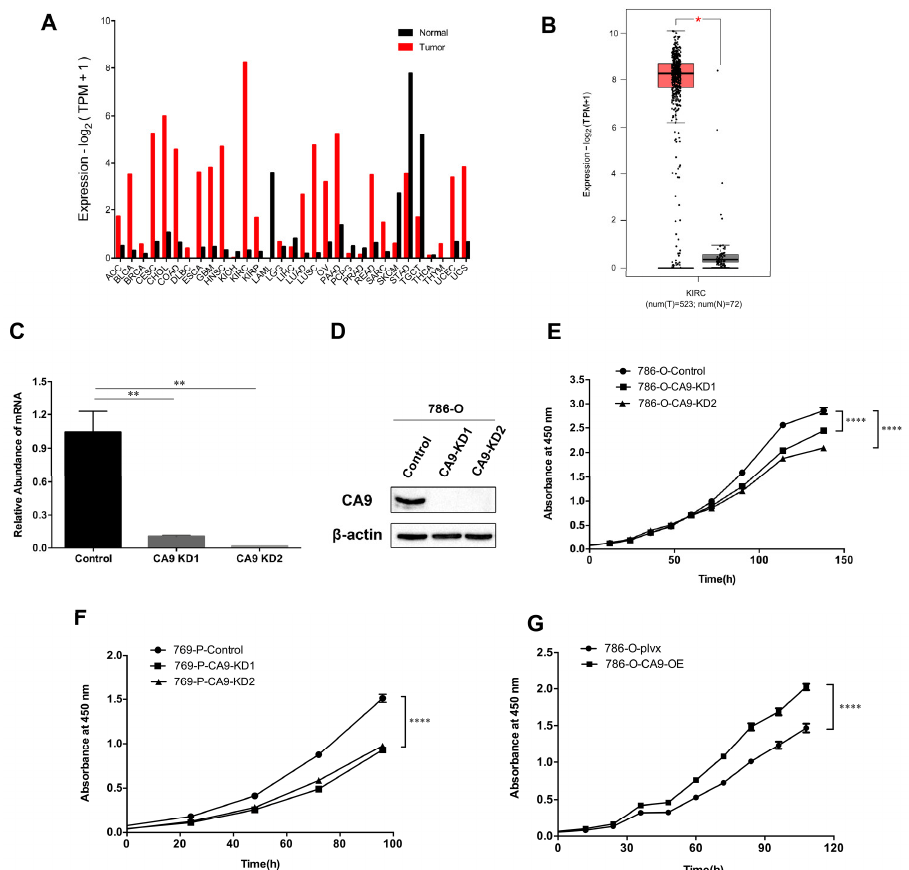
Figure 1. CA9 knockdown inhibits cell growth in clear cell renal cell carcinoma (ccRCC) cells. ( A ) CA9 expression profile across all tumor samples and paired normal tissues. The transcriptome datasets were obtained from The Cancer Genome Atlas (TCGA). Tumor abbreviations are listed in Table S1. ( B ) The mean mRNA level of CA9 in ccRCC tissues (num(T) = 523) and normal tissues (num(N) = 72) from TCGA data. ( C ) mRNA expression of CA9 decreased in 786-O-CA9-KD cells compared with control cells, measured by quantitative real-time PCR (qPCR). ACTB was used as a control. ( D ) Western blotting of CA9 revealed that the expression of CA9 was reduced in 786-O-CA9-KD cells. β -actin was used as a control. ( E ) Knockdown of CA9 in 786-O cells inhibited cell growth compared with control cells. ( F ) Knockdown of CA9 in 769-P cells inhibited cell growth. ( G ) Overexpression of CA9 in 786-O cells promoted cell proliferation. Cell proliferation curves measured by the Cell Counting Kit-8 (CCK-8) assays. Significance was calculated by Student’s t-test. **** p < 0.0001, ** p < 0.01, * p < 0.05; n = 3, mean ± SEM.